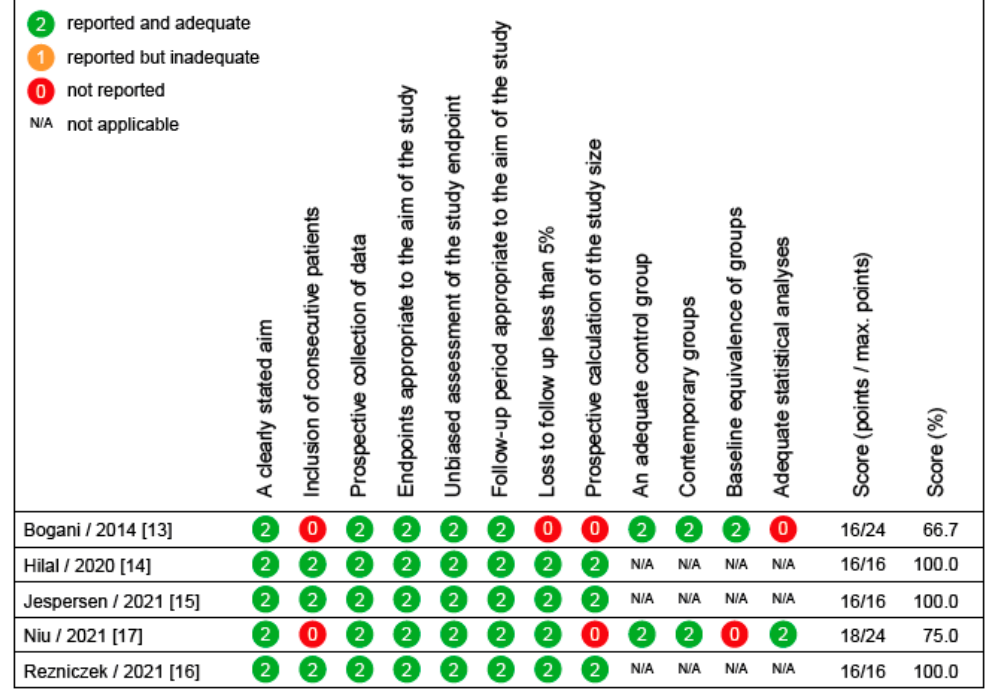
Figure 4. Methodological quality assessment and scores of prospective, non-randomized trials ( n = 5), according to the revised methodological index for non-randomized studies (MINORS; [12]).